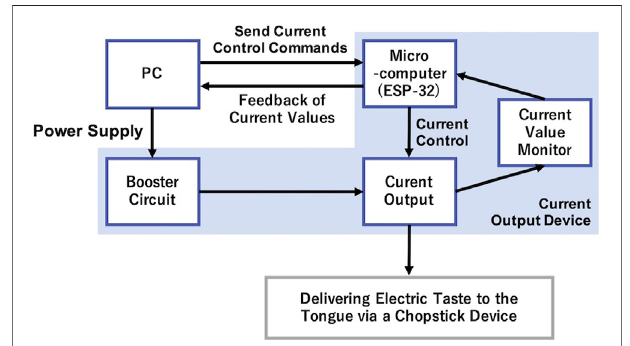
FIGURE 2 | Current output device con fi guration (Kaji and Miyashita, 2021).